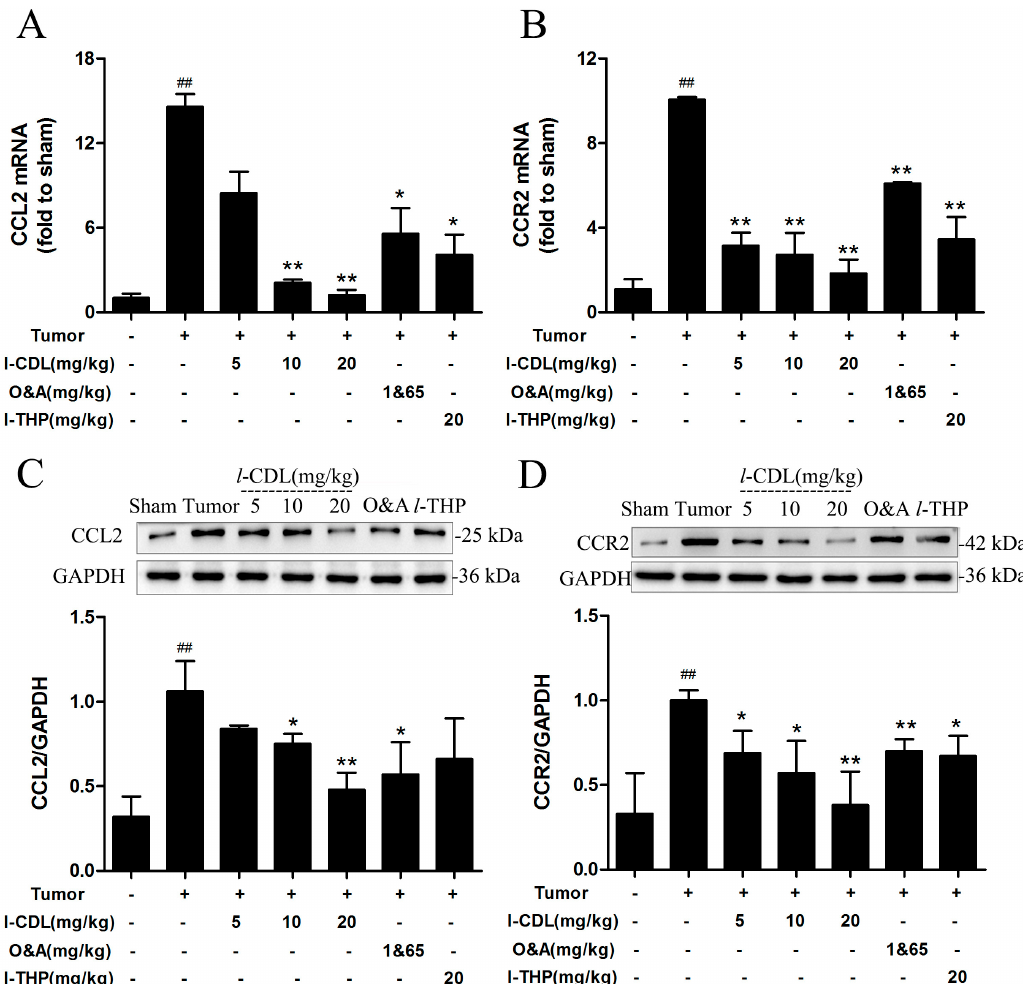
Figure 5. l -CDL attenuated tumor compression-induced CCL2 and CCR2 expression in the spinal cord. ( A ) The expression of CCL2 mRNA in the spinal cord; ( B ) The expression of CCR2 mRNA in the spinal cord; ( C )The level of CCL2 protein in the spinal cord; ( D ) The level of CCR2 protein in the spinal cord. ## p < 0.01 vs. the sham group; * p < 0.05, ** p < 0.01 vs. the tumor group (mean ± S.D., n = 3).